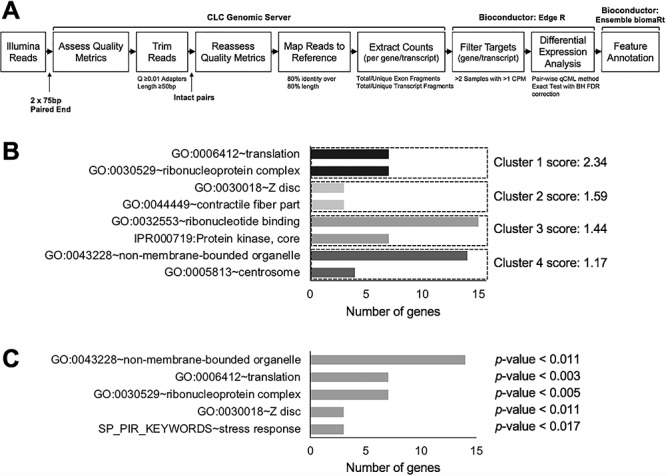
RNA-Seq analysis of Tdrd7−/− lens. (A) Bioinformatics pipeline for analyzing RNA-Sequencing data; delineating various steps for quality control, adaptor removal, sequence integrity, sequence mapping, estimating counts per transcript and differential analysis. (B) Gene ontology (GO) analysis of 49 differentially expressed genes with fold change (FC) >1.5 and FPKM >10 expression in lens tissue. (C) GO analysis of 85 differentially expressed genes with FC >1.5 and FPKM > 5 expression in lens tissue. (C) GO analysis of 168 differentially expressed genes with FC >1.5 and FPKM > 2 expression in lens tissue.